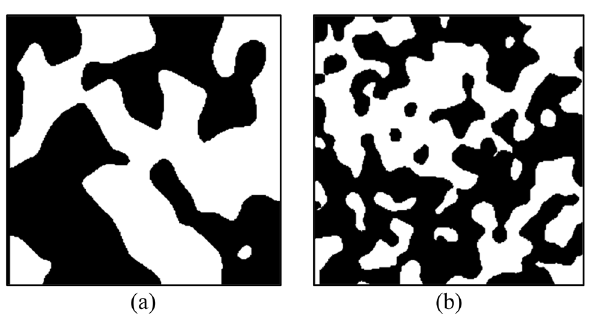
Figure 2. Cross-sectional view of the samples, obtained by Espinoza et al. 43 , with the same porosity (ε = 0.5) and different blobiness. The left side ( a ) corresponds to a porous media with blobiness of 0.5, while the right ( b ) represents a porous media with blobiness equal to 1.0.